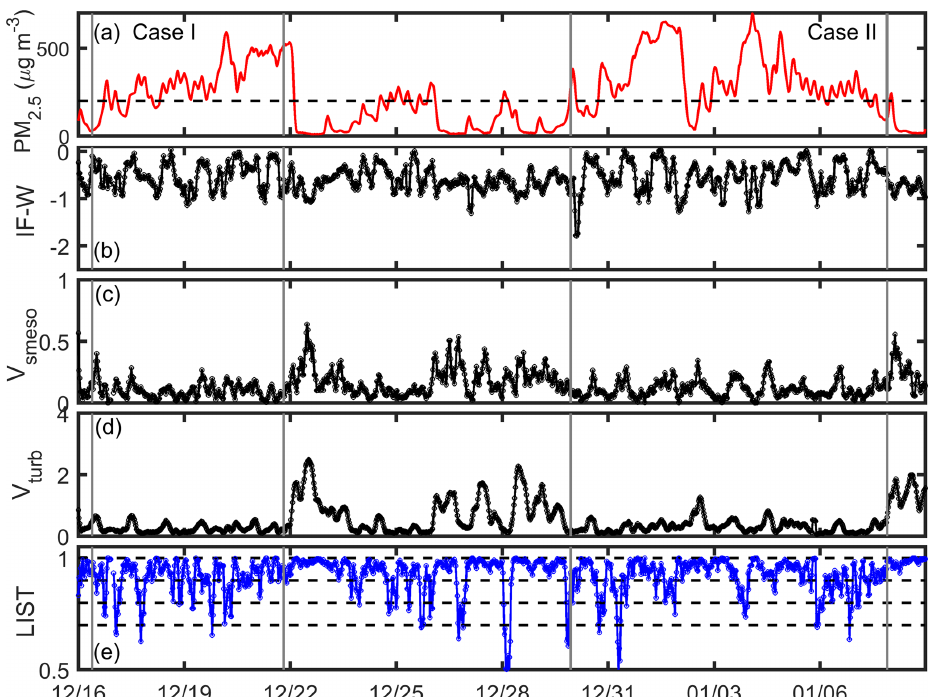
Figure 7. Time series of the (a) PM 2 . 5 concentrations, (b) intermittency factor (IF) of vertical velocity, (c) velocity scale of submesoscale motions ( V smeso ), (d) velocity scale of turbulence ( V turb ), and (e) LIST from 16 December 2016 to 8 January 2017 at the suburban